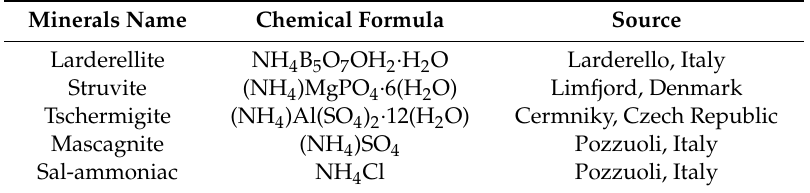
Table 1. Chemical formula, minerals’ name and provenances of the selected studied samples. Minerals